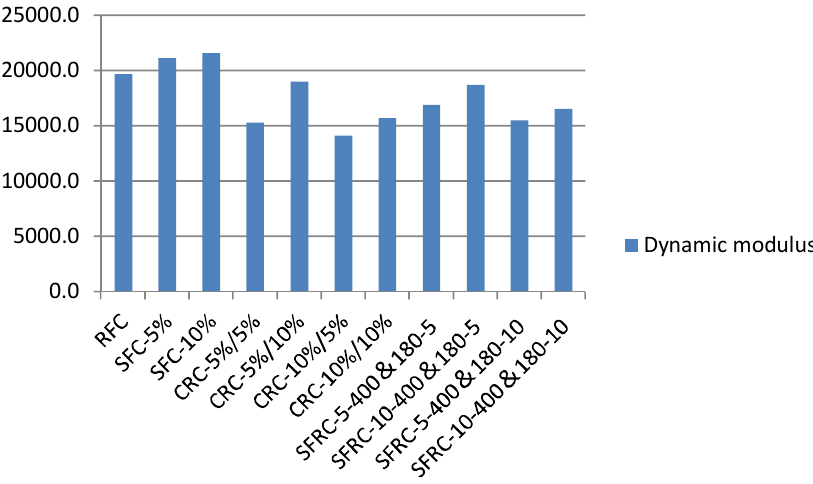
Figure 22. Dynamic moduli of crumb rubber concrete at 28 days (MPa).